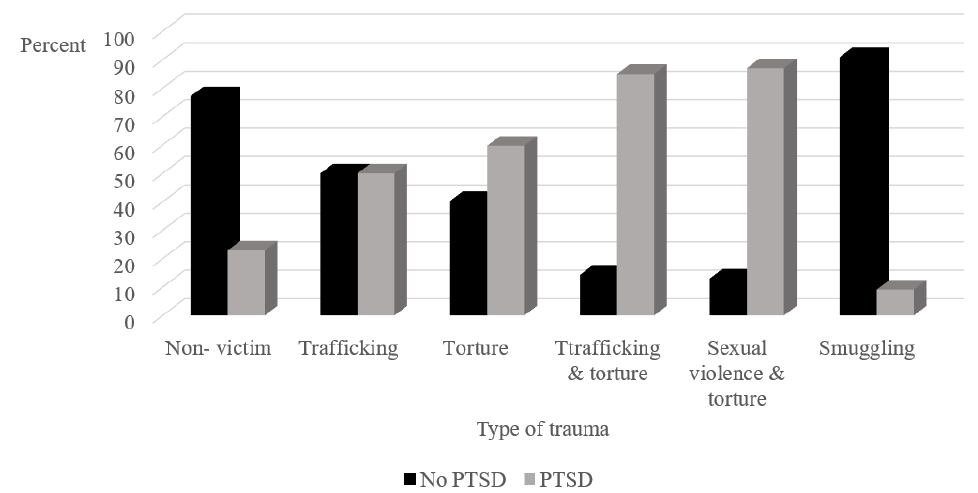
Figure 2. Percentage of asylum seekers who experienced trauma en route to Israel, with and without PTSD as a function type of trauma. PTSD = Post-traumatic stress disorder.